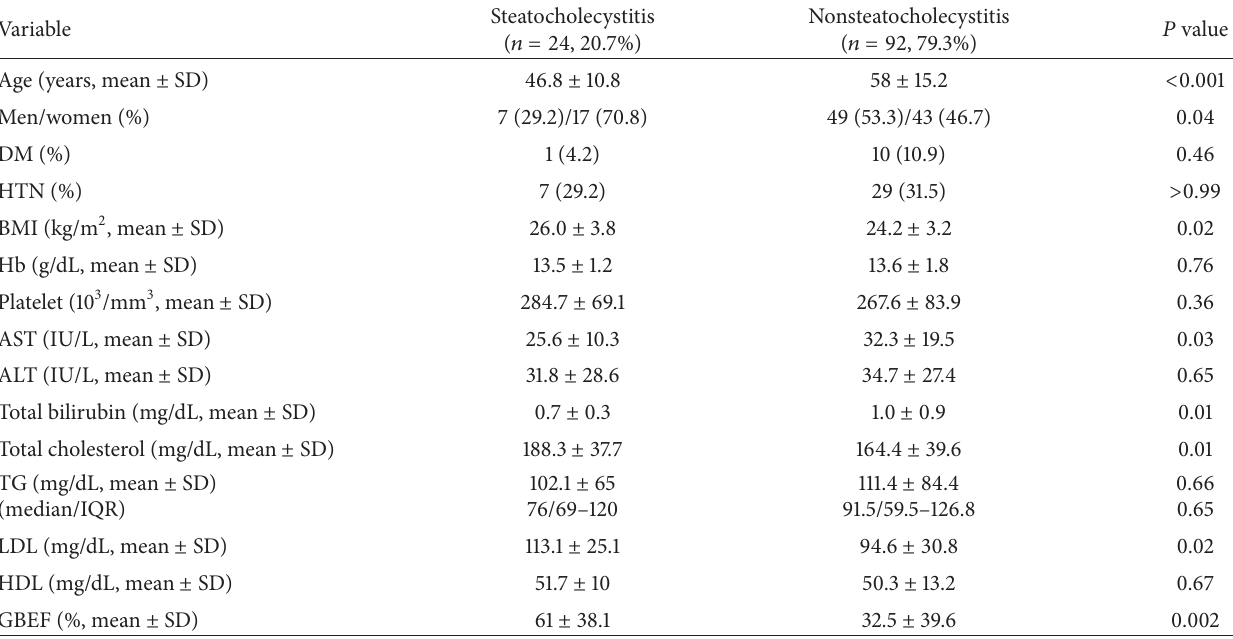
Table 3: Univariable analysis for clinical risk factors of steatocholecystitis in patients with acalculous cholecystitis. Variable